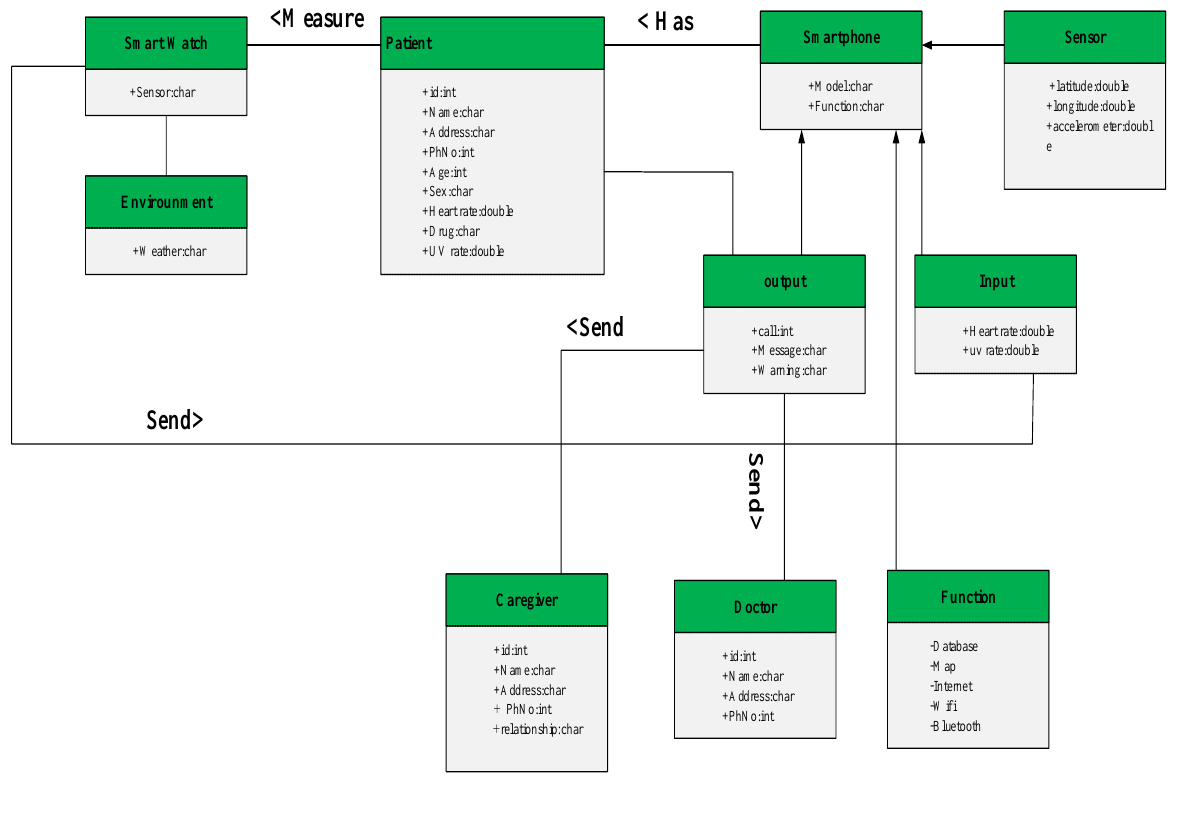
Figure 4. class diagram of the designed